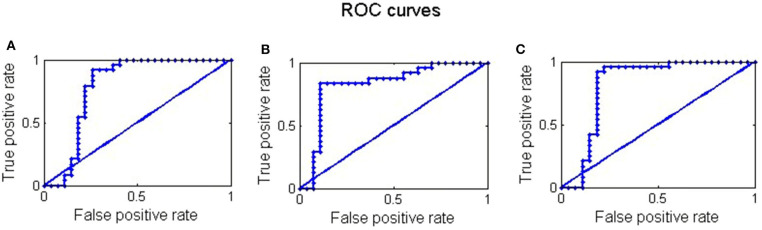
ROC curves of the linear SVM classifier using (A) intra-in IFS of the vPCC_L, (B) intra-in+out IFS of the PCC_L, and (C) intra+inter-out IFS of the PCC_R within the DN as classification features. PCC, posterior cingulate cortex; vPCC, ventral posterior cingulate cortex.